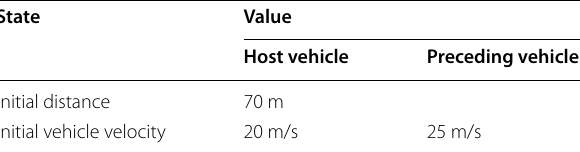
Table 2 Critic network structure